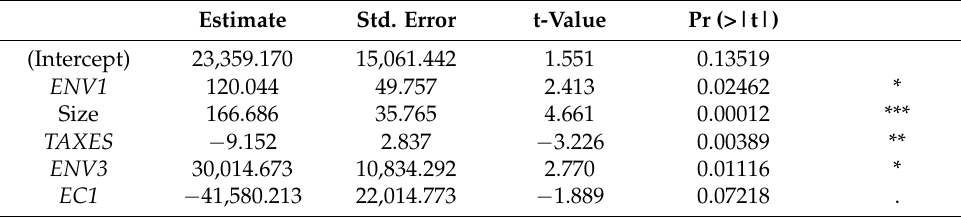
Table 4. Results of regression analysis for the income indicator FNI